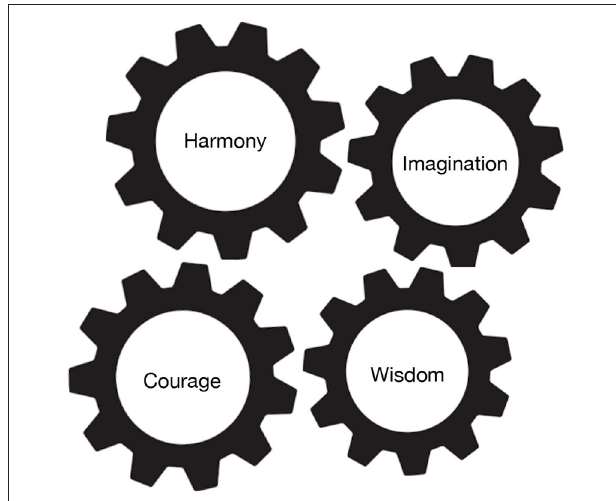
FIGURE 1 | Leadership habits of the